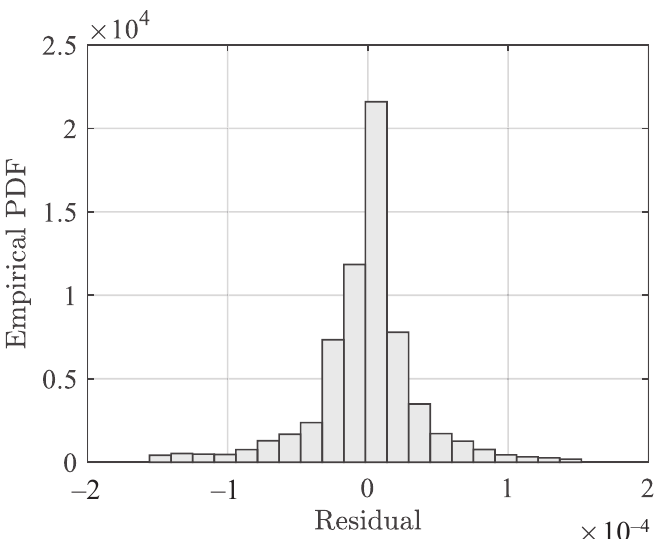
Figure 9. Histogram of residuals of the temperature-dependent stress–strain model (Equation (6)) on tension data.